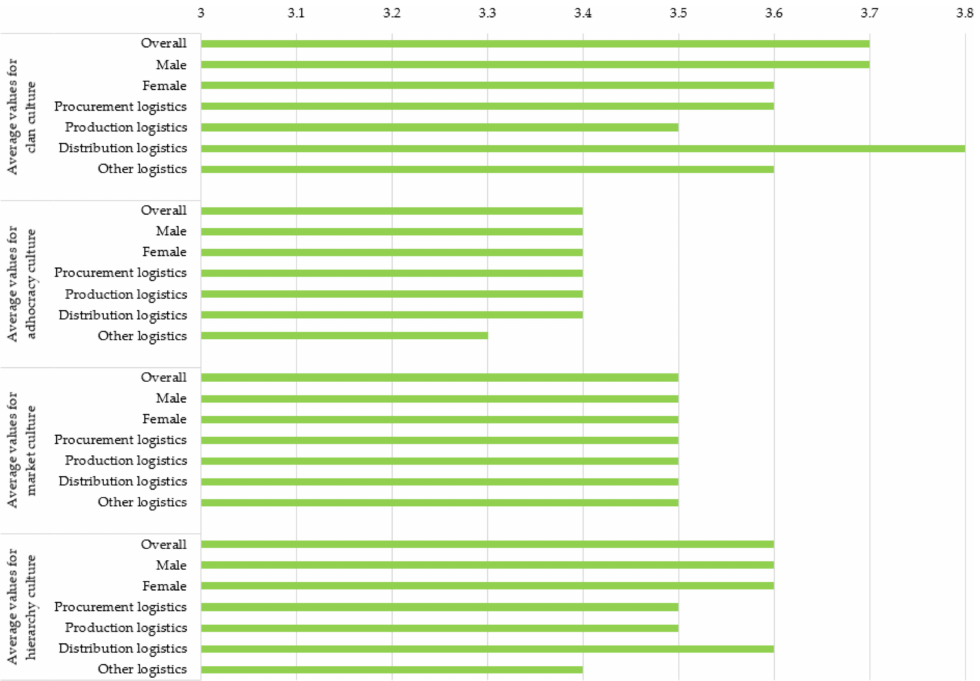
Figure 4. Current status of OC by its types in sample enterprises (1 means a very low value, 5 means a very high